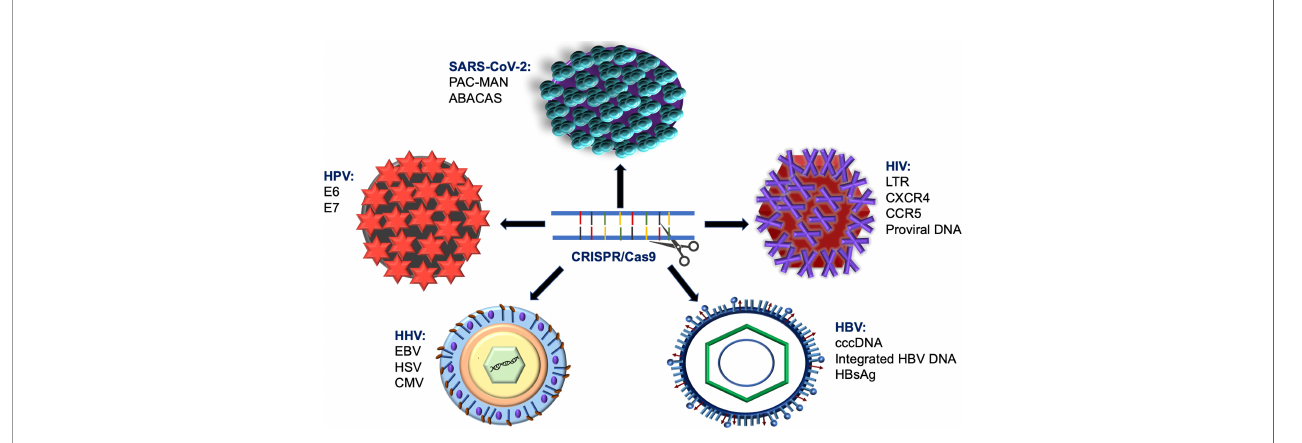
FIGURE 3 | Shematic diagram describes using of CRISPR/Cas9 system in targeting various types of